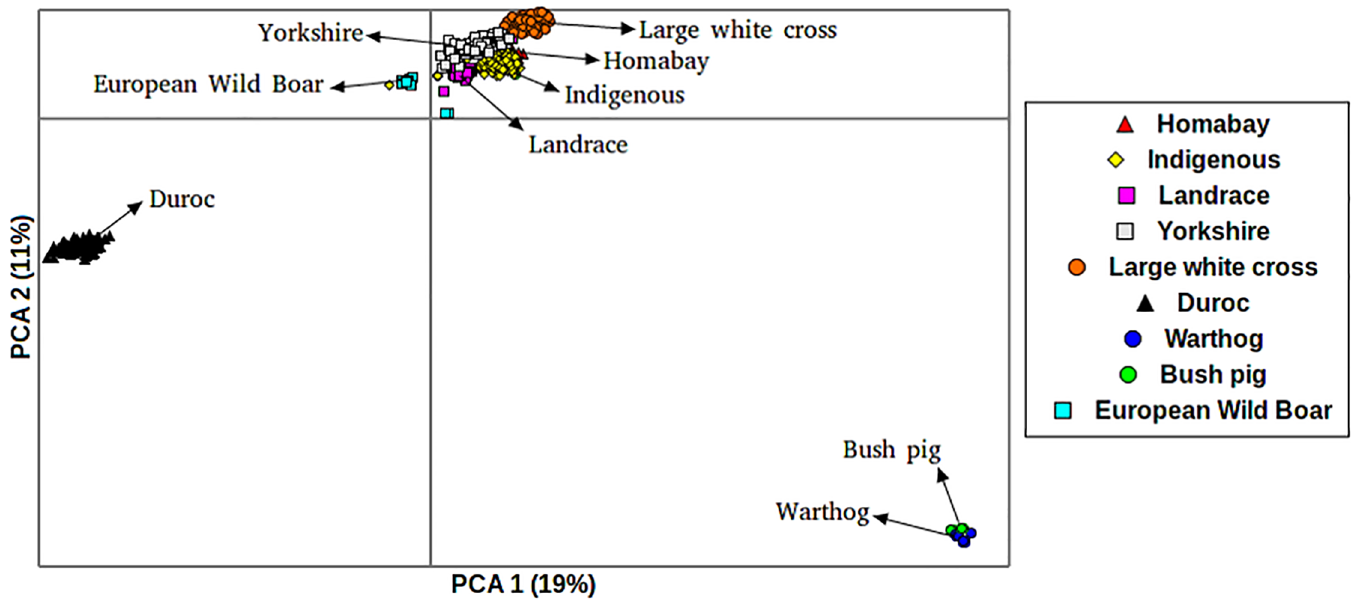
Fig 1. PCA plot for pigs indicating their distribution along the first two